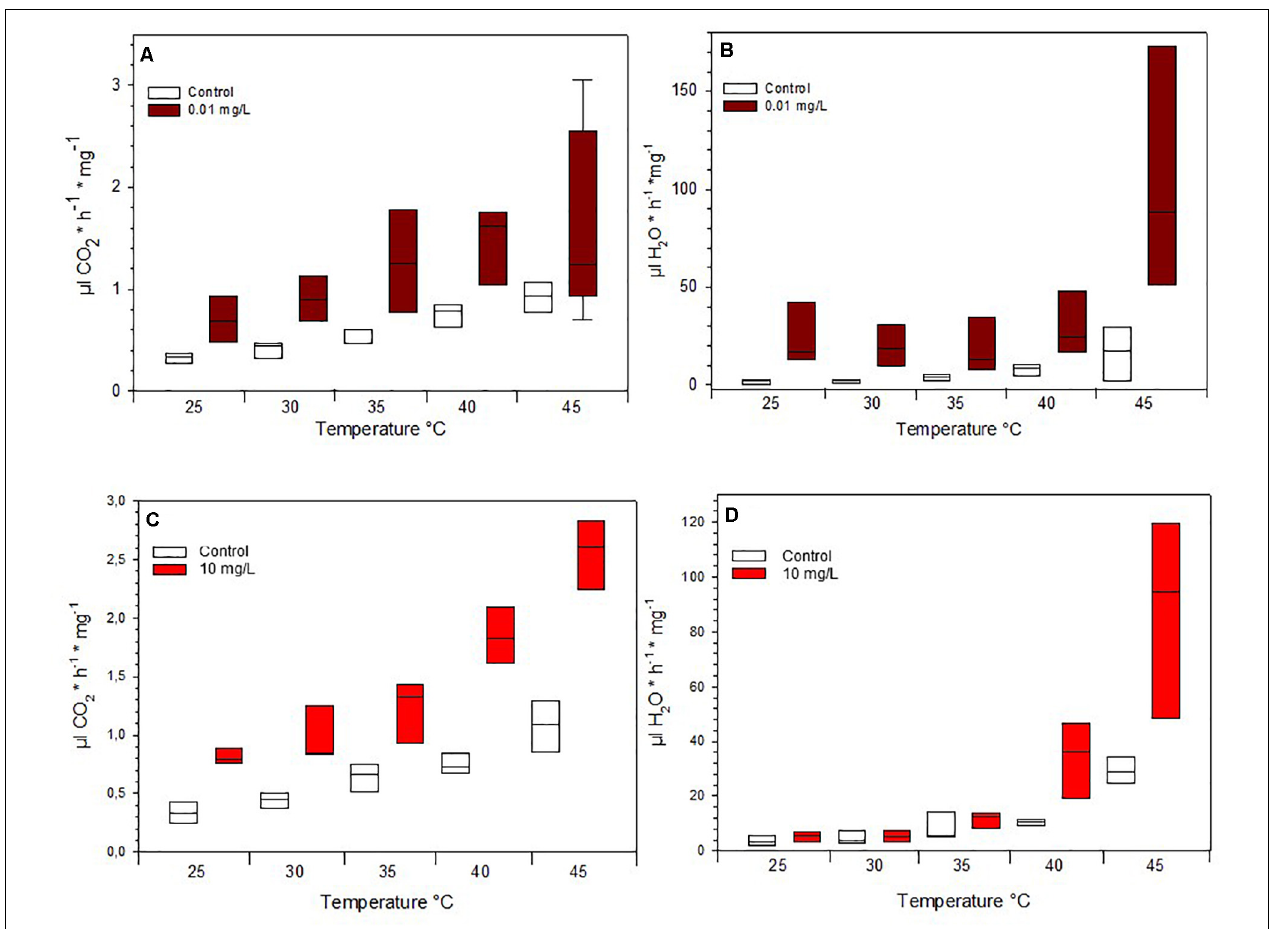
FIGURE 3 | Mass-specific metabolic rate of (A) Spinetoram exposed insects and a control group at different temperatures and (C) of Azadirachtin exposed insects and a control group. Mass-specific water loss of (B) Spinetoram exposed insects and a control group at different temperatures and (D) in Azadirachtin exposed caterpillars and a control